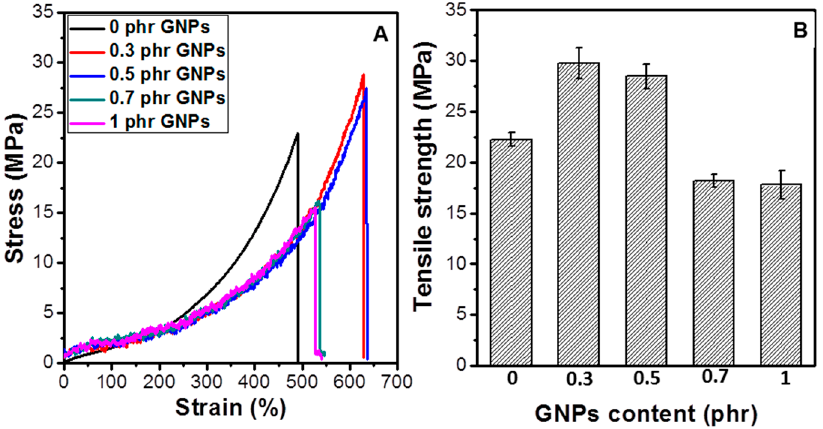
Figure 5. ( A ) Stress-strain curves of all the control samples and GNPs/natural rubber composites; ( B ) tensile strength properties of GNPs/natural rubber